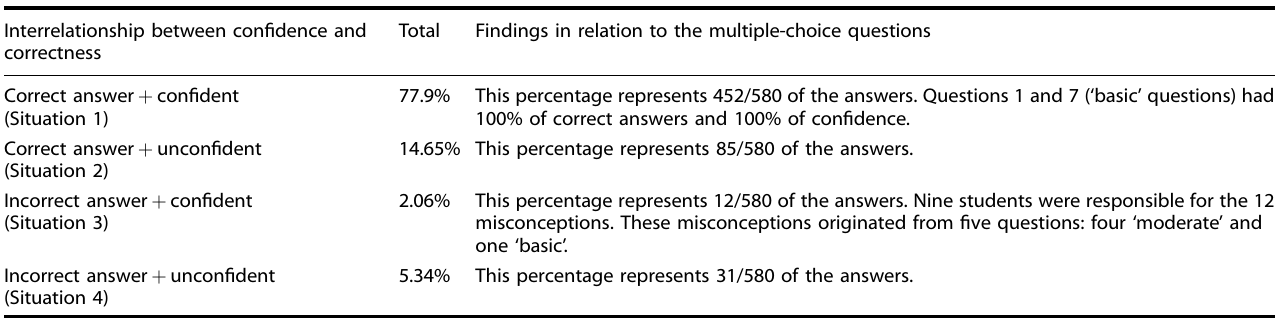
Table 2. Interrelationship between con fi dence and correctness and other important fi ndings in relation to the questions. Interrelationship between con fi dence and correctness Correct answer + con fi dent (Situation 1) Correct answer + uncon fi dent (Situation 2) Incorrect answer + con fi dent (Situation 3)